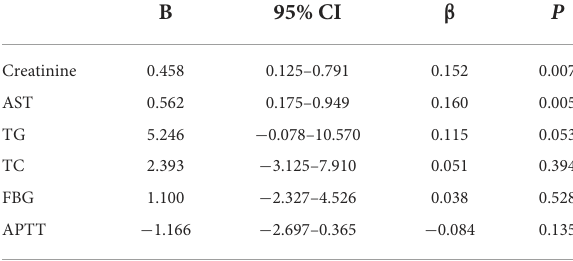
TABLE 3 Multivariable linear regression analysis on the association between baseline factors and the percent change of lipoprotein(a) levels.